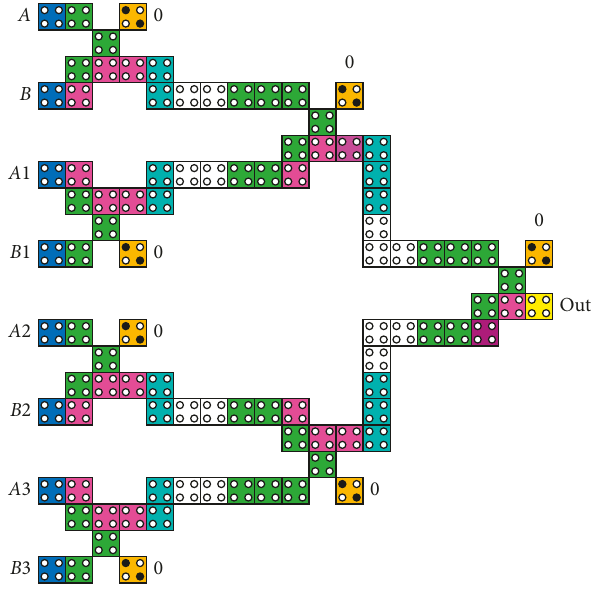
Figure 8: QCA implementation of the proposed 8bit parity generator